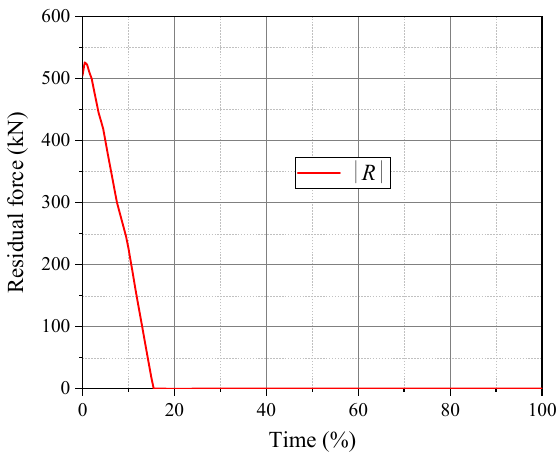
Figure 10. The stress distribution of control cables.